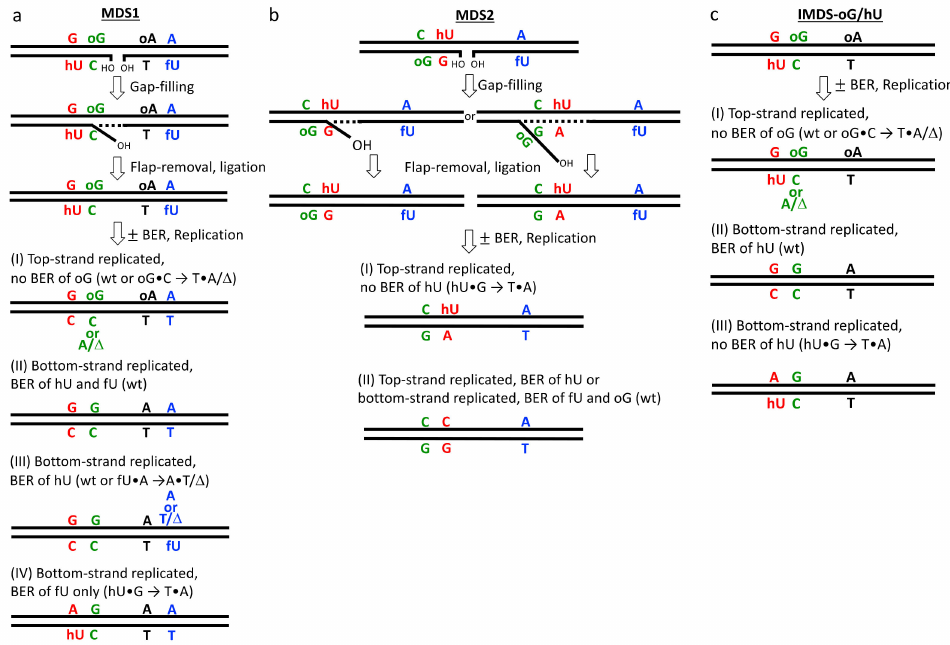
Figure 6. Models for in vivo processing of MDS1 ( a ), MDS2 ( b ), or IMDS-oG/hU ( c ), leading (or not) to mutations. Most probable events are shown, based on mutation spectra and in vitro data (see Section